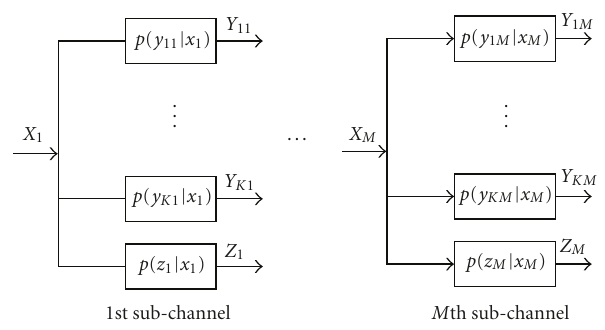
Figure 3: The parallel multireceiver wiretap